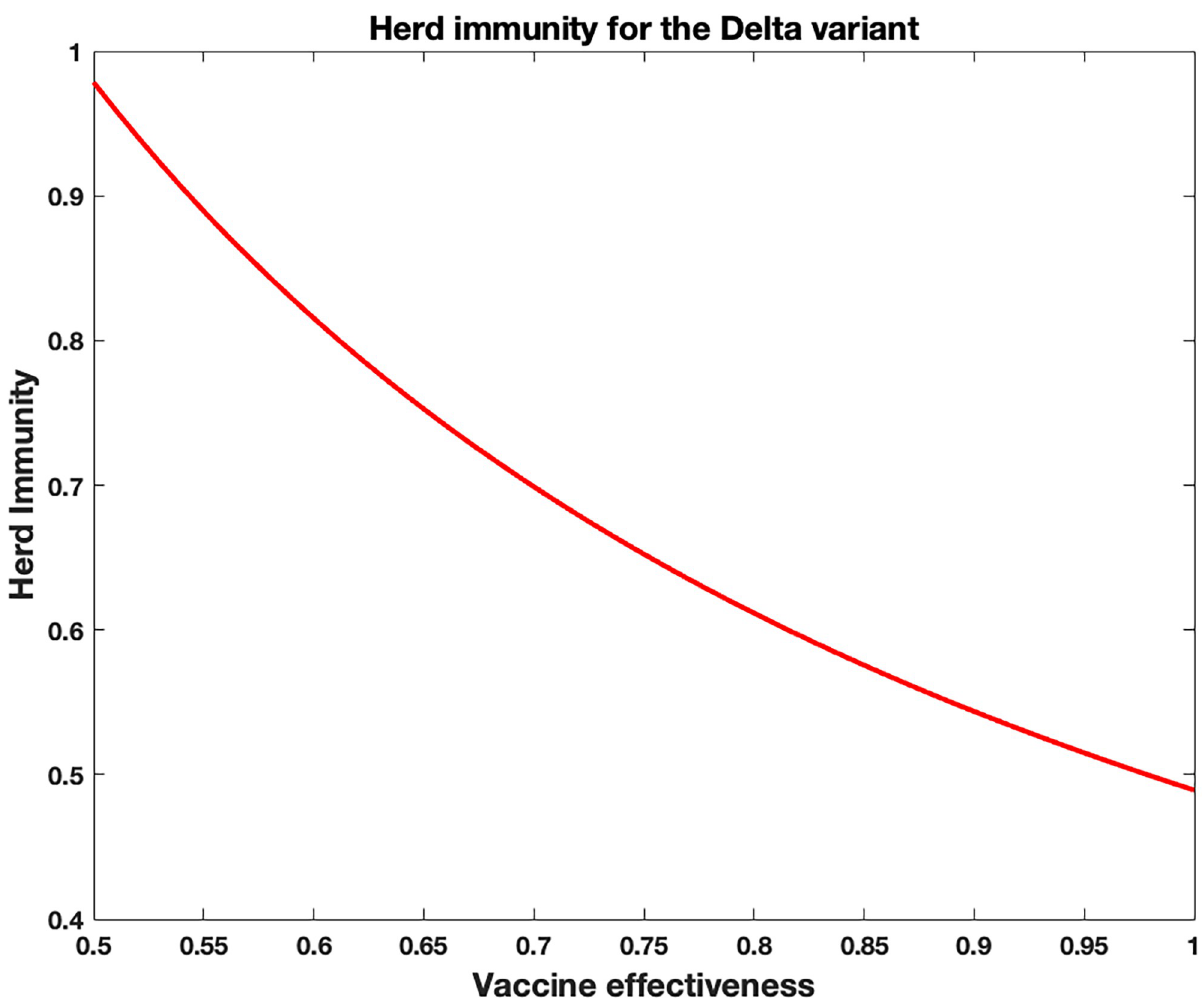
Fig 11. Herd immunity as a function of the measure of the effectiveness of vaccines for the Delta variant in the United States.